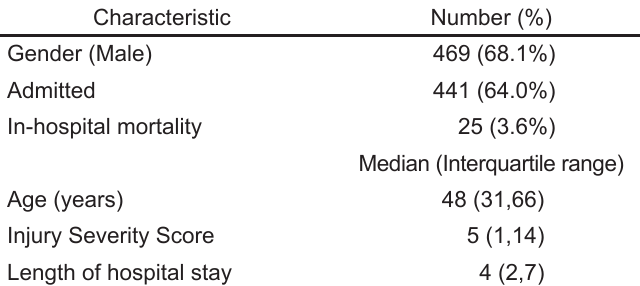
Table 2. Patient characteristics (N =